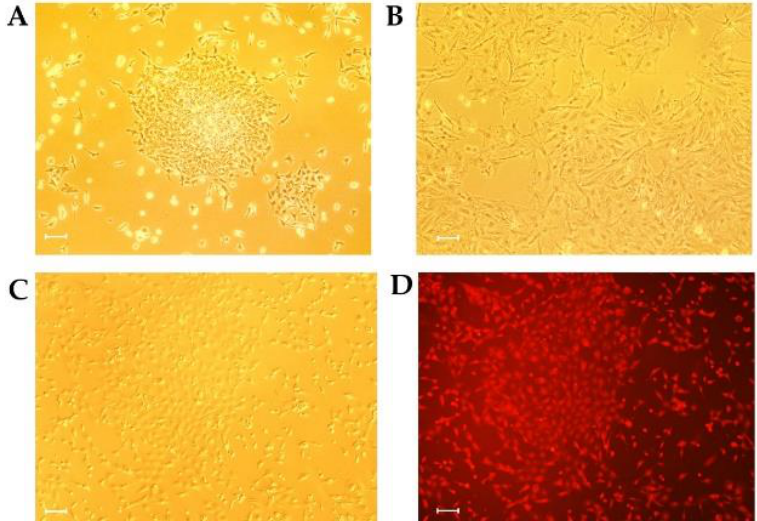
Figure 2. Isolation of granulosa cells (GCs) and transfection with Tet-on 3G Large T lentivirus. ( A ) The primary GCs were isolated from the ovary tissue and cultured at day 1. ( B ) The primary culture GCs were differentiated on the fifth day. ( C , D ) GCs with expression of Large T and mCherry maintained long-term proliferation as primary culture GCs. Bar at 50 µm.